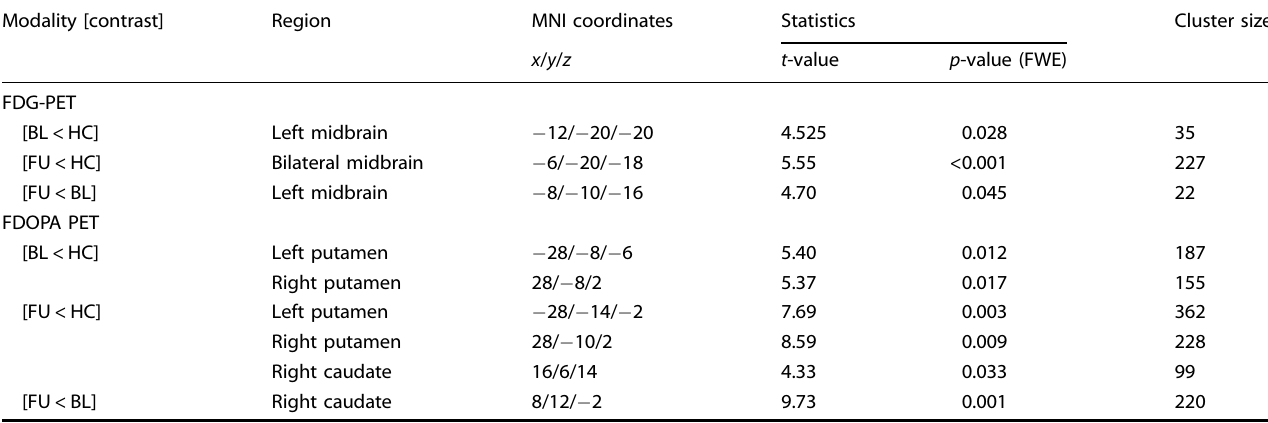
Table 2. Results of PET neuroimaging